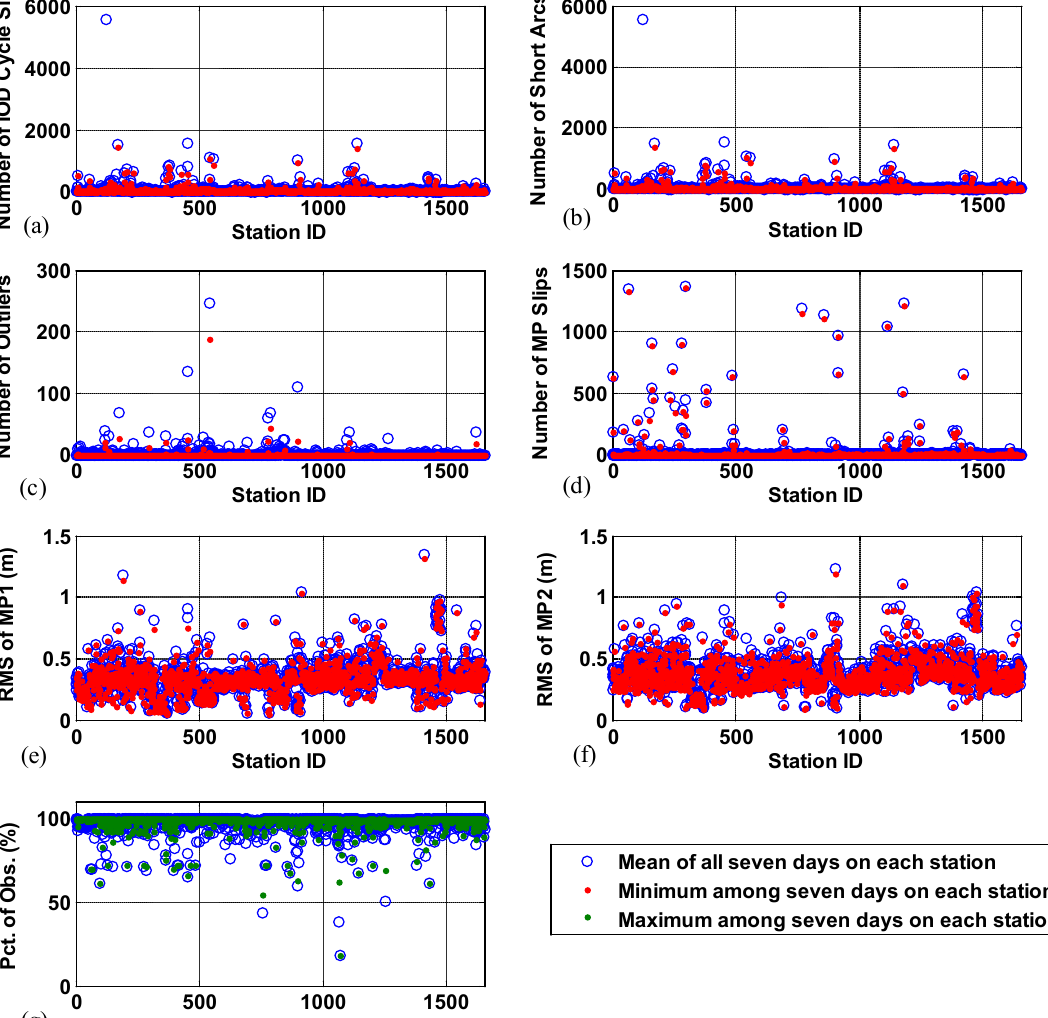
Figure 8. Data quality parameters obtained at each station per day: ( a ) number of IOD cycle slips; ( b ) number of short arcs; ( c ) number of outliers; ( d ) number of MP slips; ( e ) RMS of MP1; ( f ) RMS of MP2; and ( g ) percentage of